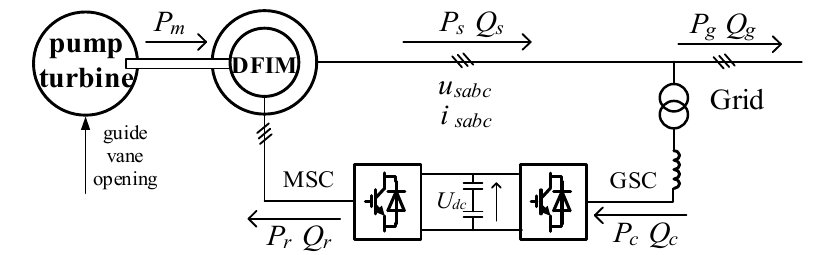
Figure 1. Structure diagram of the DFVSPS.